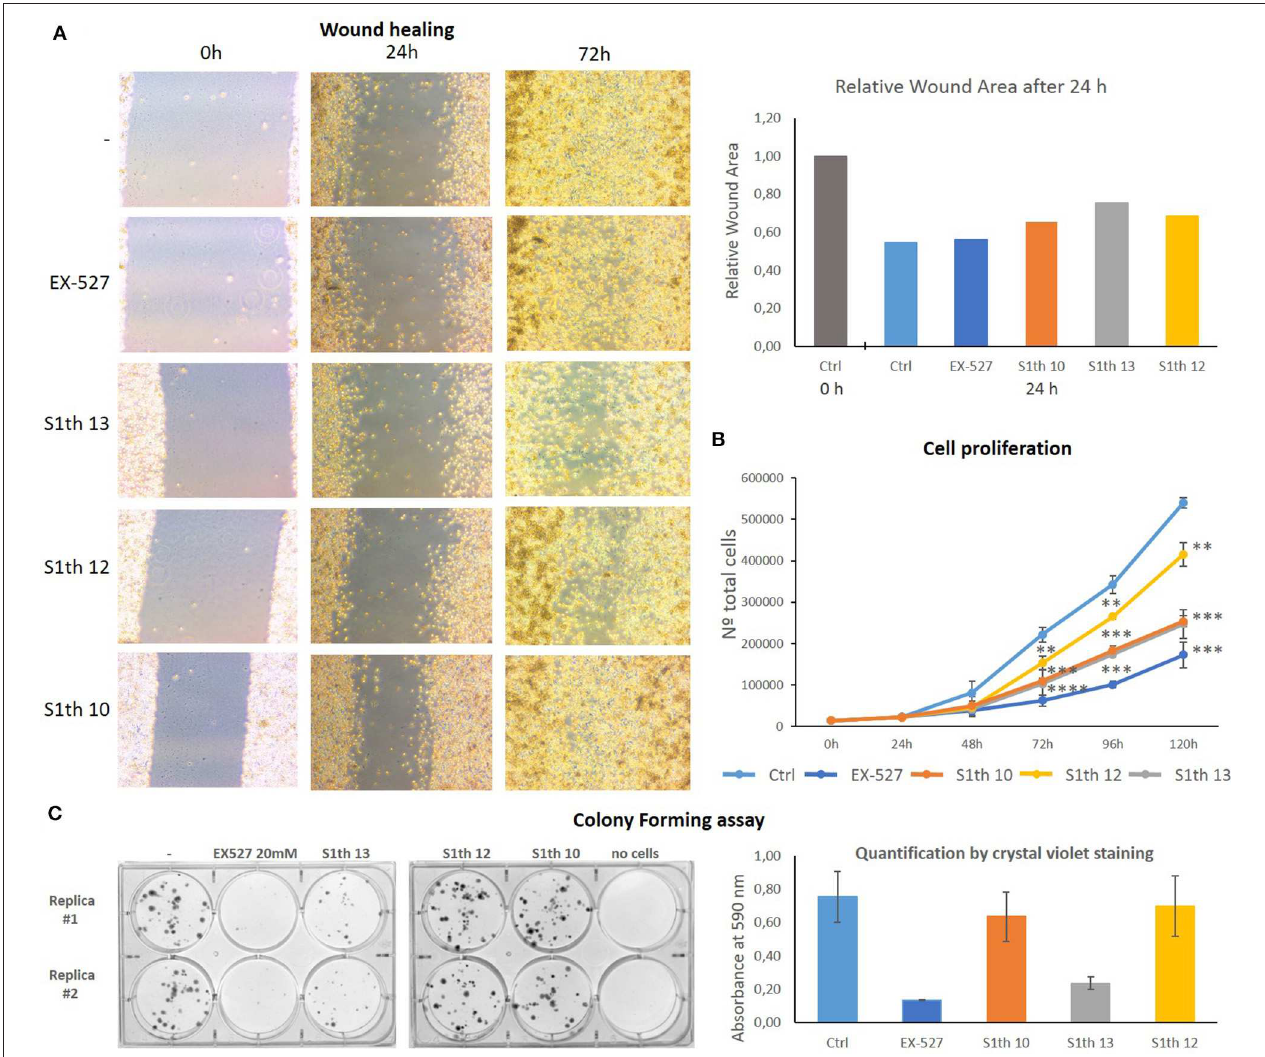
FIGURE 5 | (A) Impact of EX-527 and S1th 10 , 12, and 13 on cell migration of HeLa cells in a wound healing assay. All compounds were able to impair cell migration. The S1th showed a clear effect already after 24h, while a decrease of migration only came apparent after 72h for the positive control EX-527. This experiment was only carried out once. (B) Impact of S1th 10 , 12, and 13 and EX-527 on cell proliferation of HeLa cells. All compounds are able to slow down cell proliferation of HeLa cells, with S1th 12 only showing a mild effect. The experiments were performed at least three times each. * p < 0.05, ** p < 0.01, *** p < 0.001, **** p < 0.0001. (C) Impact of EX-527 and S1th 10 , 12, and 13 on colony forming capabilities of HeLa cells. Colony forming is significantly decreased by EX-527 and S1th 13 , but barely affected by S1th 12 and 10 . Experiments were carried out in duplicates and quantification was done by staining the colonies with crystal violet and measuring absorbance at